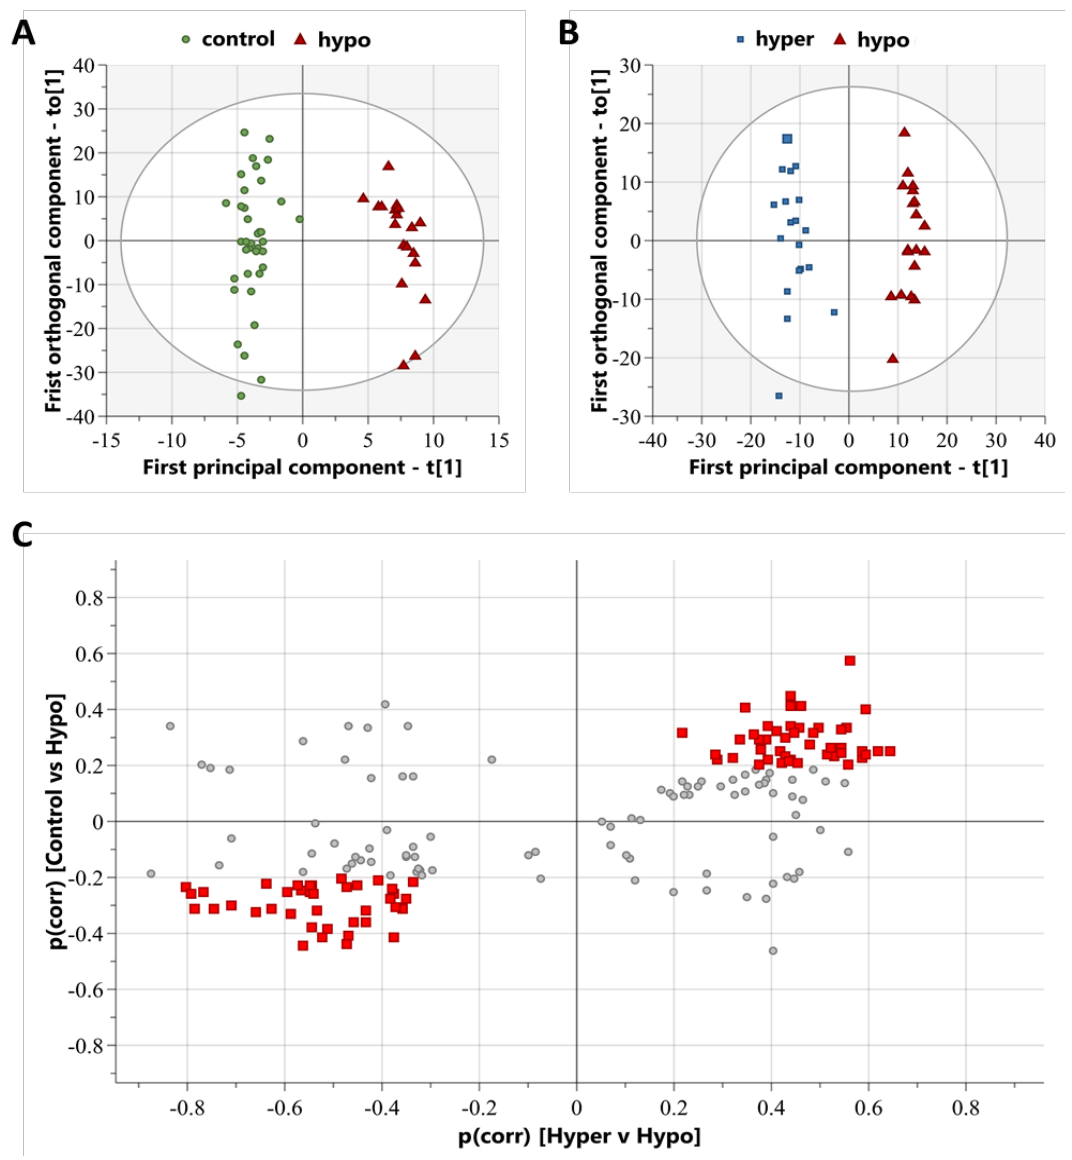
Figure 1. Multivariate modeling can be used to distinguish study groups and highlight metabolite features discriminating the hypo group. ( A ) Orthogonal partial least squares discriminant analysis (OPLS-DA) score plot of the model comparing control (green circles) and hypo (red triangles) groups, R2 = 0.96, Q2 = 0.72, CV-ANOVA < 0.001. ( B ) OPLS score plot of the model comparing hyper (blue squares) and hypo (red triangles) groups, R2 = 0.96 and Q2 = 0.86. ( C ) Shared-and-unique structures (SUS) plot highlighting metabolite features (red squares) that discriminate the hypo group from the hyper and control groups. SUS plot was built from the two OPLS-DA plots, with control vs. hypo on the y -axis, and hyper vs. hypo on the x -axis. Hypo group discriminating features (red squares) distribute along the diagonal, with the threshold set as p(corr) < − 0.2 and p(corr) > 0.2. Non-discriminating features are those plotted as grey circles.